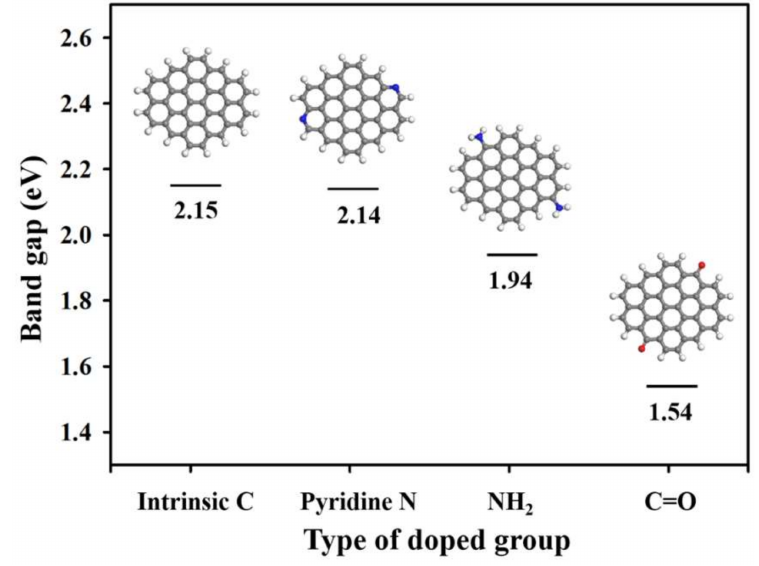
Figure 5. Band gap change of CDs as a function of the doped groups (inset images are optimized structures of CDs) (C: gray; N: blue; O: red; H: